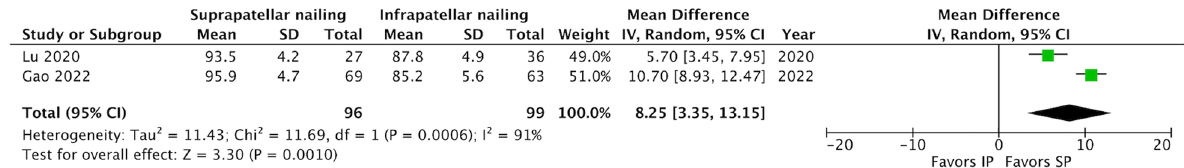
Fig. 4 Forest plot of ankle function assessed by the AOFAS score 12 months after surgery. The SP group had a clinically significantly higher AOFAS score than the IP group (MD: 8.25 points; 95% CI 3.35 to 13.15; P difference, CI confidence interval